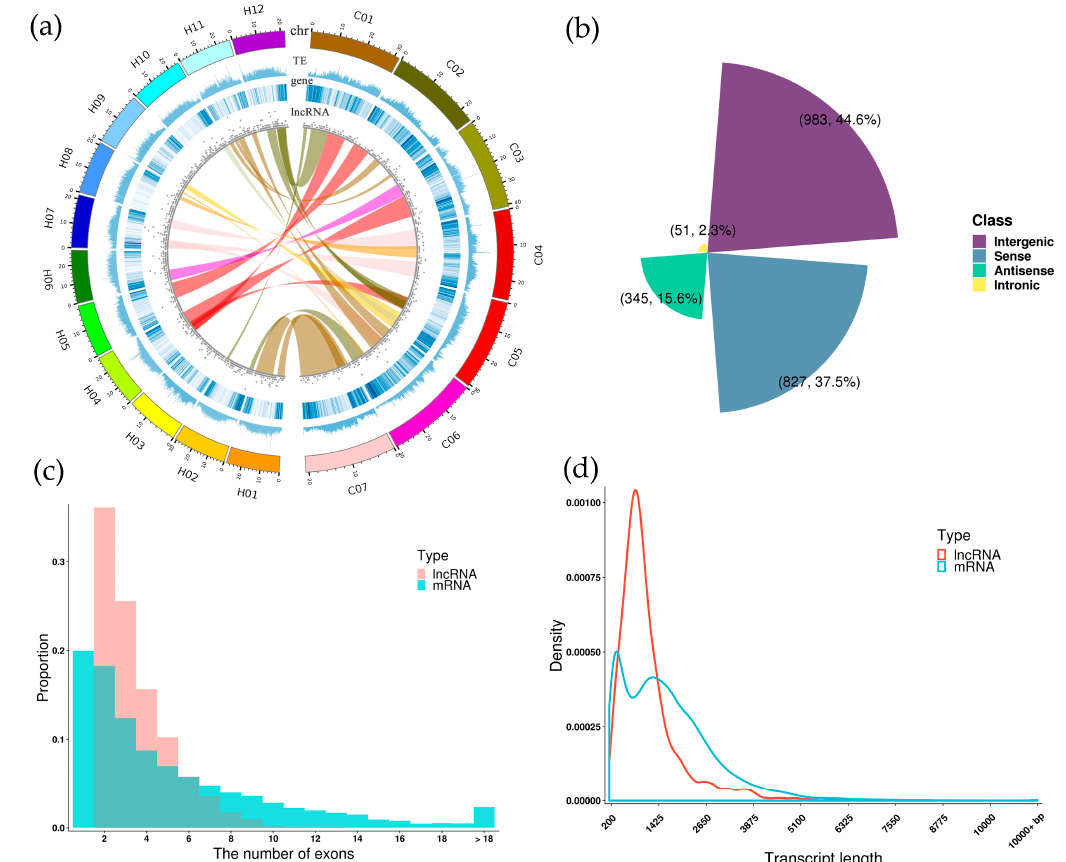
Figure 2. Description of the sequence characteristics of lncRNAs in C. hytivus leaves. ( a ) Analysis of 2 the lncRNAs along each chromosome, showing density of genes, transposon elements, and lncRNAs in physical bins of 100 kb for each chromosome. The circles from inside to outside represent lncRNA, gene, transposon elements (TE), and chromosomes (chr). The internal collinear bands represent 145 lncRNAs in 23 synteny blocks. The scale for the chromosomes (outer bars) is Mb. ( b ) Numbers of intergenic, intronic, antisense, and sense lncRNAs in C . hytivus leaves. ( c ) Numbers of exons of lncRNAs in comparison with protein-coding transcripts of C . hytivus . ( d ) Comparison of the transcript length distributions of lncRNAs and